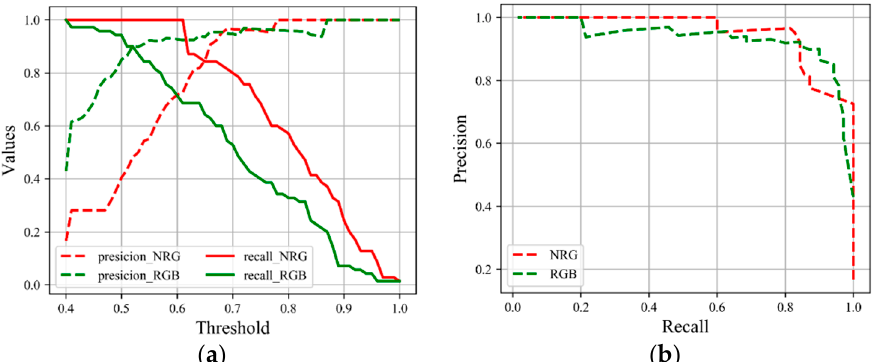
Figure 11. Performance of different band combinations: ( a ) precision and recall on different confidence thresholds, ( b ) precision–recall curves for different color modes.